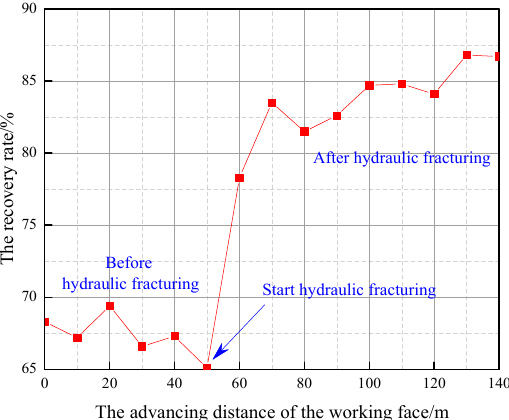
Figure 14. The variation of the coal recovery ratio with working face advancing.